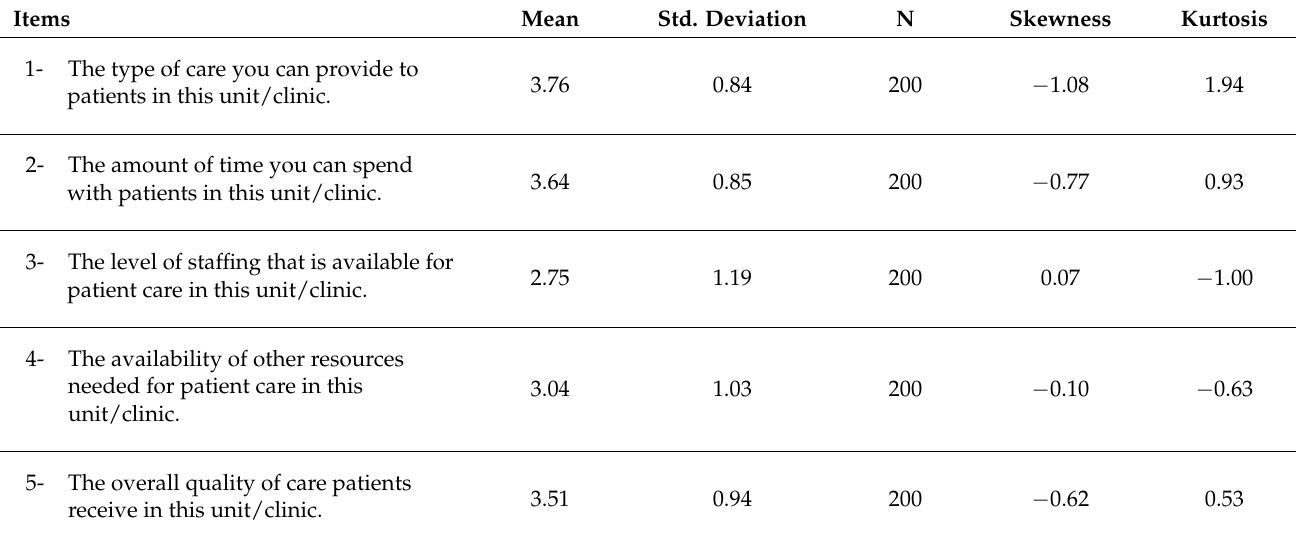
Table 1. Descriptive statistics of the five items of the